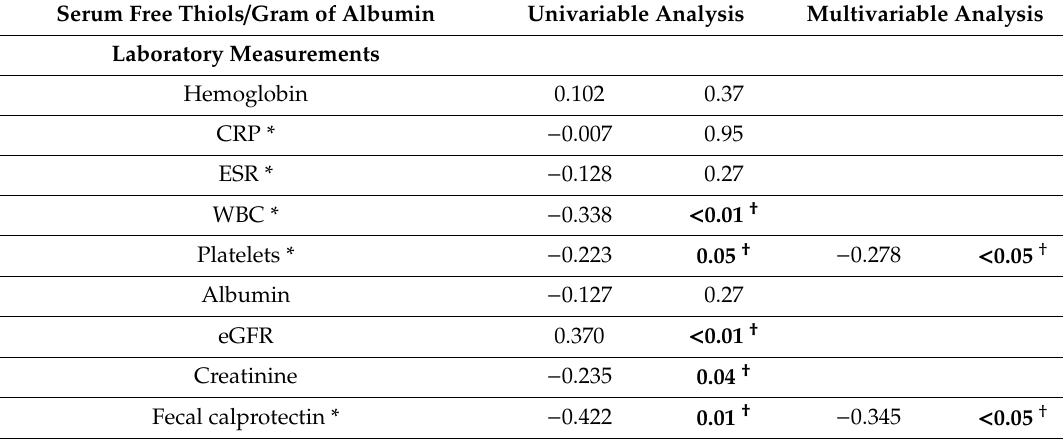
Figure 2. Albumin-adjusted serum free thiols are significantly decreased in ( A ) IBD patients, ( B ) CD patients and ( C ) UC patients with severe endoscopic disease activity as compared to mild disease activity (** P < 0.01; * P < 0.05). 3.5. Discriminative Accuracy of Serum Free Thiols regarding Endoscopic Disease Activity As a next step, albumin-adjusted serum free thiols were evaluated in terms of their discriminative accuracy to differentiate mild disease activity (SES-CD or Mayo category 1) from moderate-to-severe endoscopic disease activity (SES-CD or Mayo categories 2 and 3) (Figure 3). In the IBD cohort, serum levels of albumin-adjusted free thiols significantly discriminated patients with mild disease activity from patients with moderate-to-severe disease activity (area under the curve (AUC) = 0.76, 95% confidence interval (CI) 0.64–0.89, P < 0.01, Figure 3A and Table S3). For comparison, the AUC for fecal calprotectin levels was 0.66 (95% CI 0.42–0.89, P = 0.23, n = 28, Figure 3B and Table S3). Fecal calprotectin levels closest to the date of endoscopy were incorporated into